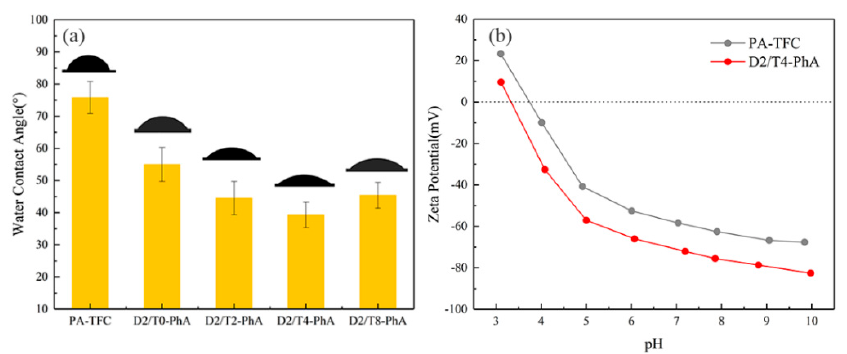
Figure 3. ( a ) Water contact angles and ( b ) zeta potentials of PA-TFC membrane and DA/TA-PhA membranes.